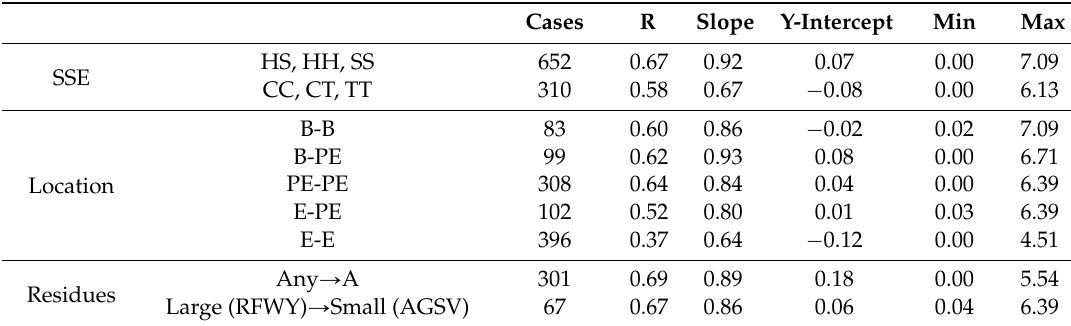
Table 4. Performance of Single Amino Acid Folding free Energy Changes (SAAFEC) method in predicting the effect of specific groups of mutations. Cases R Slope